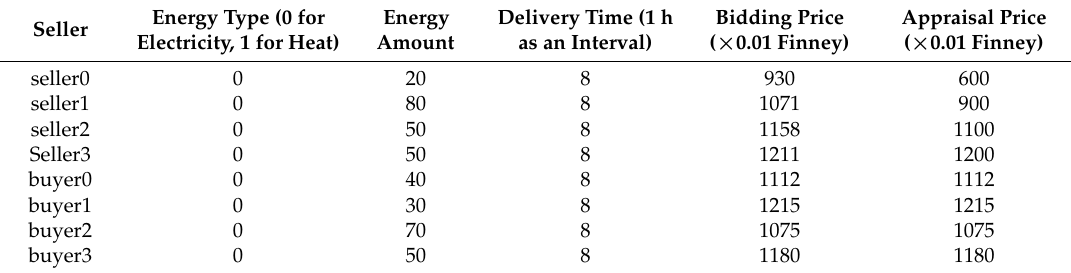
Table 9. The bidding of buyers and